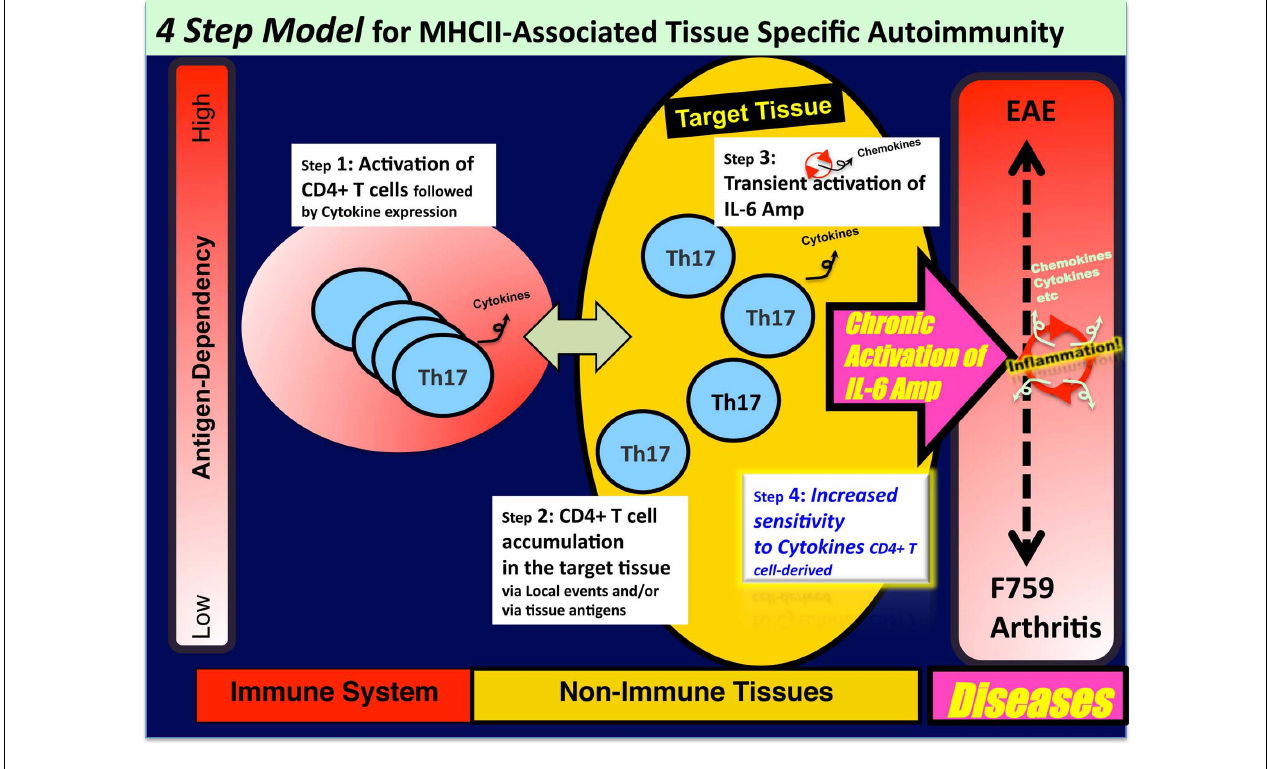
enhanced sensitivity toT cell-derived cytokines and/or IL-6 in type 1 collagen + cells in the target tissue. Following these four steps, chronic activation of the IL-6 amplifier followed by the development of an autoimmune disease occurs. It is likely that each step interacts with the others, and the degree of the contribution of each to the pathogenesis varies with the